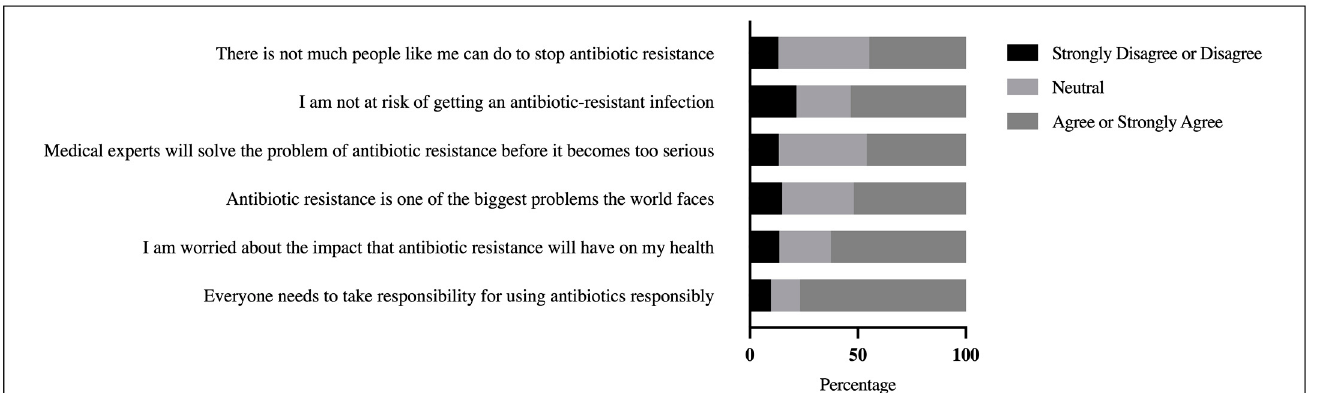
Figure 2. Participants’ perspectives on the scope of the antibiotic resistance problem. Table 6. Participants’ awareness and perspectives concerning antibiotics in relation to variables of interest.